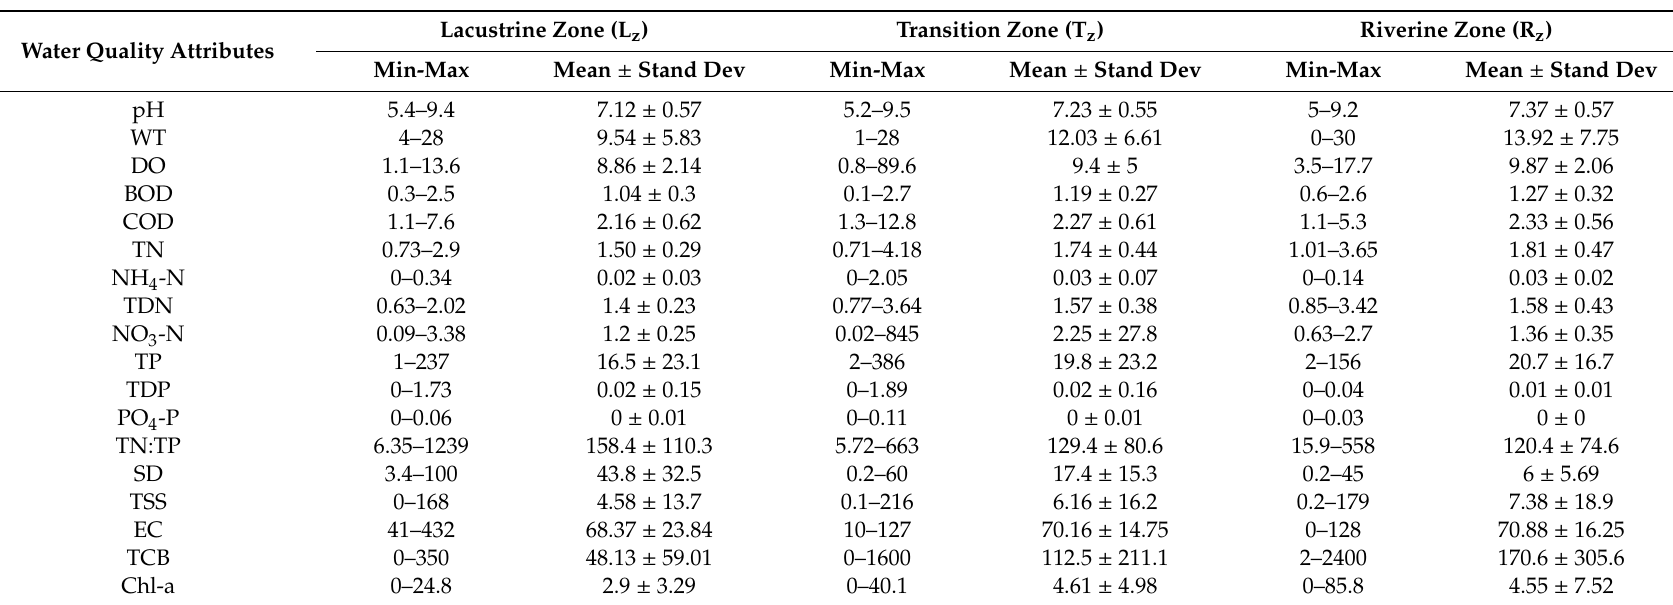
Table 1. Summary statistics of water chemistry parameters in the three zones of the Soyang reservoir studied during 1992–2013. Water Quality